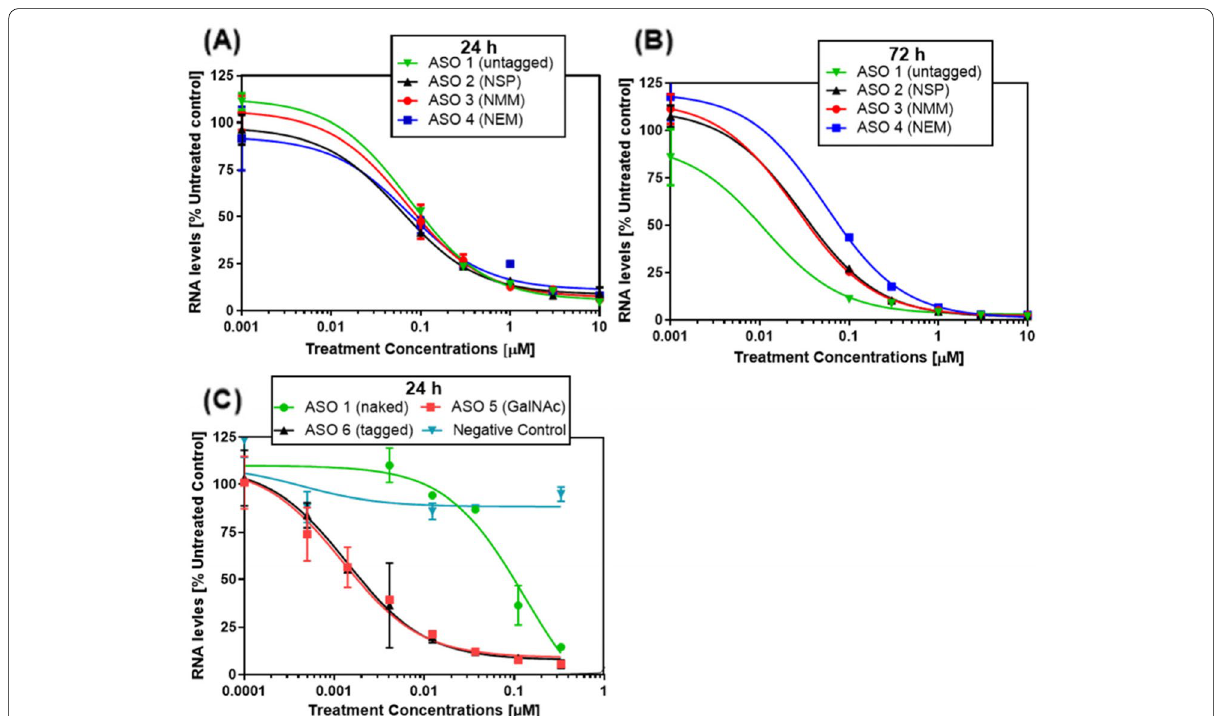
Fig. 3 Concentration-dependent target reduction in mouse hepatocytes (in vitro) treated with NSP and maleimide-tagged naked ASOs and their untagged counterpart. Malat1 RNA levels were assessed after A 24 h and B 72 h. C Malat1 RNA levels of GalNAc-conjugated oligonucleotides compared with naked-Malat1 and negative-control ASO after 24 h (mean and SD, n =